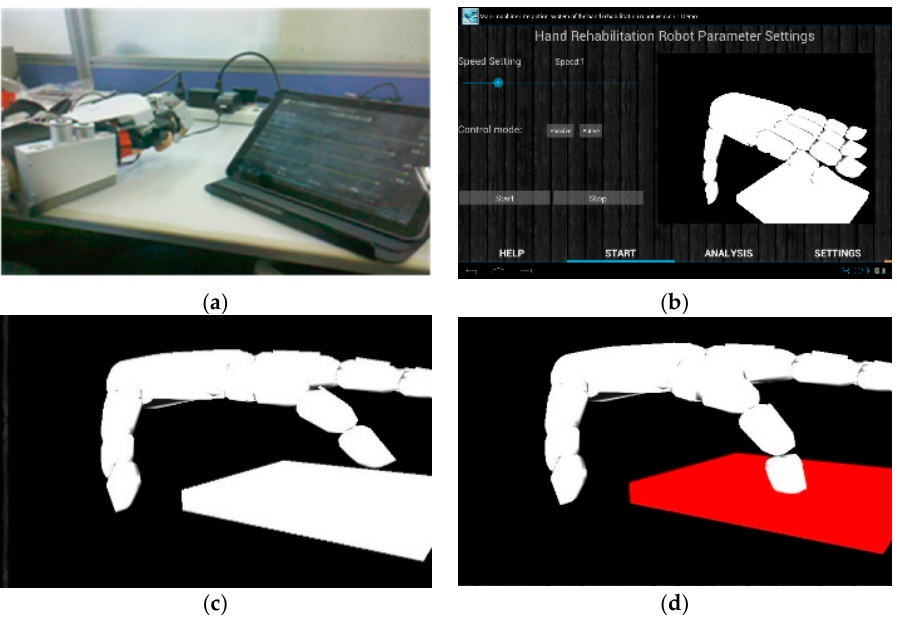
Figure 3. Android software interface: ( a ) whole system; ( b ) interface; ( c ) virtual reality rehabilitation training layer; ( d ) collision detection.